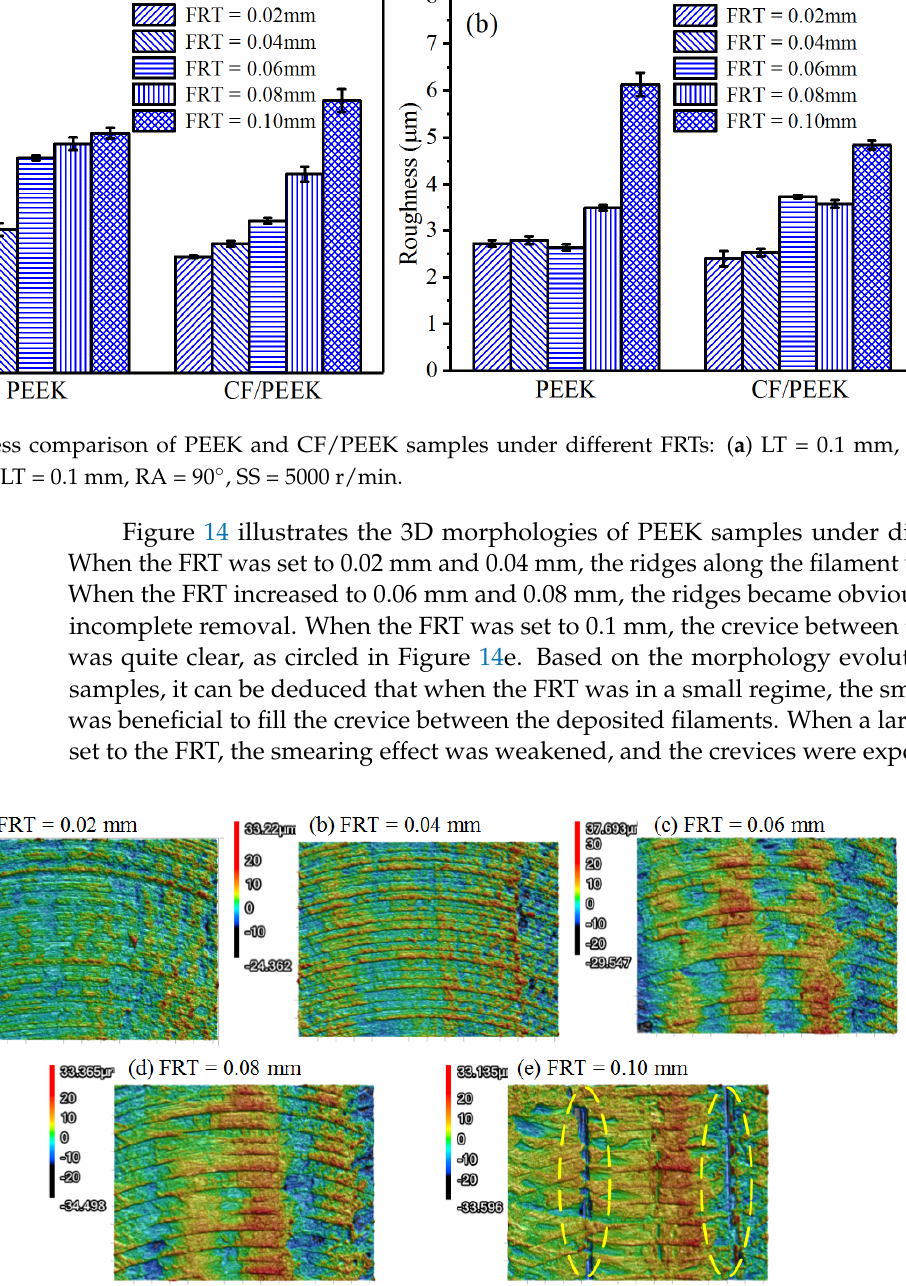
( a ) FRT = 0.02 mm; ( b ) FRT = 0.04 mm; ( c ) FRT = 0.06 mm; ( d ) FRT = 0.08 mm; ( e ) FRT = 0.10